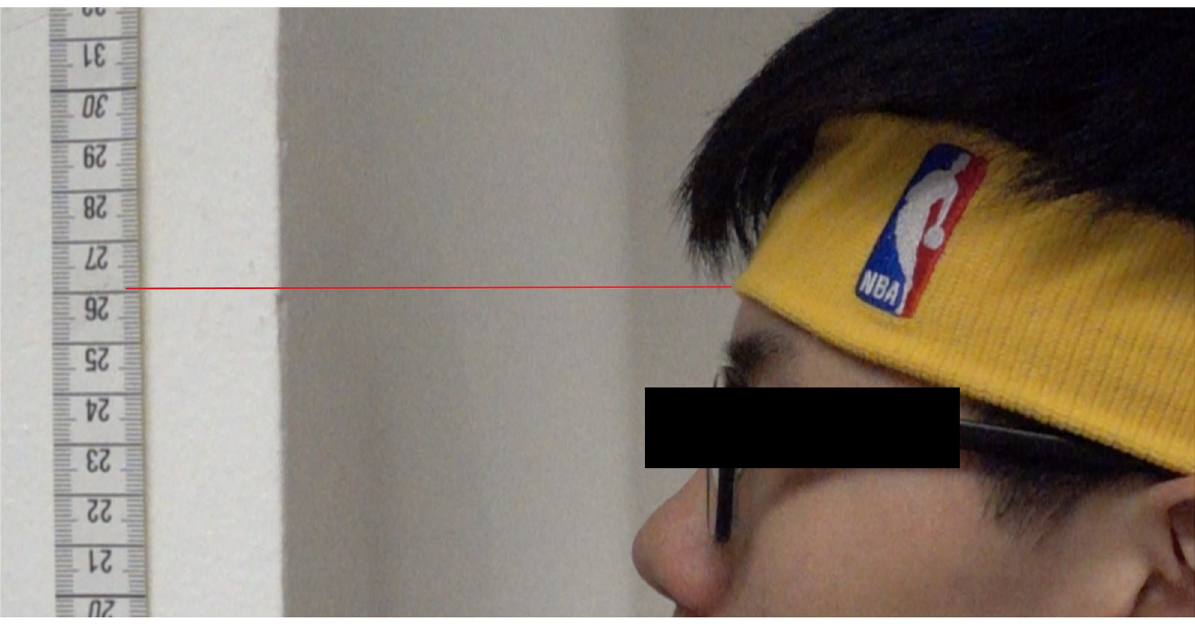
Fig 4. Marking of non-arm swing countermovement